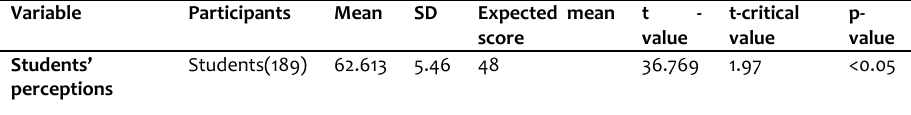
Table 4: Students’ perceptions about peer-led leaning